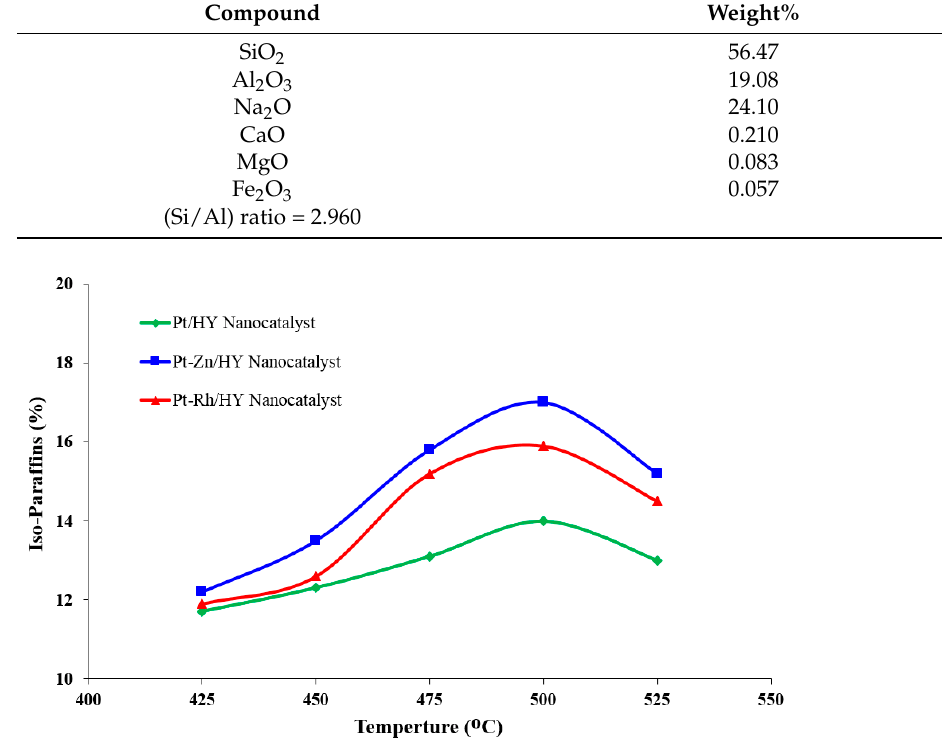
Figure 4. Influence of the catalytic reforming temperature on the iso-paraffin production rate over the synthesized Pt/HY, Pt-Zn/HY, and Pt-Rh/HY nanocatalysts.